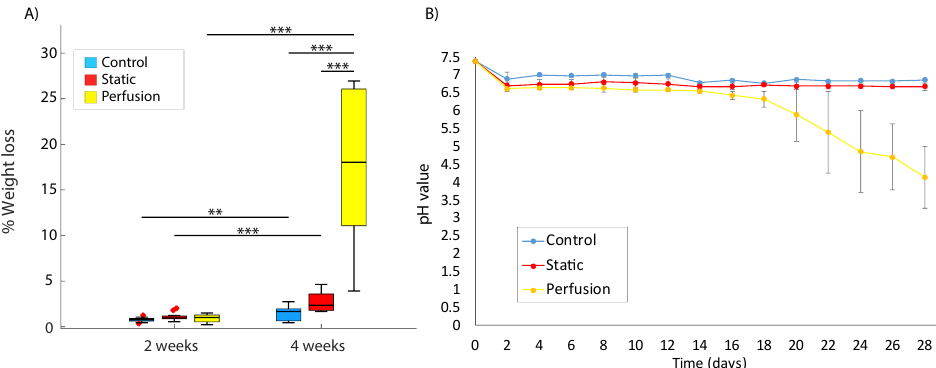
Figure 3. ( A ) Weight Loss (%) of samples after 2 and 4 weeks of incubation for the different conditions: control (blue), static (red) and perfusion (yellow). ( B ) pH variation over 4 weeks of incubation. Control values (blue) are taken by measuring PBS at 37 ◦ C every two days. Values from static (red) and perfusion (yellow) conditions were taken by measuring the collected exchanged PBS every 48 h. Significant different were assumed for a p -value < 0.05 (** p < 0.005, *** p < 0.001), x outlier